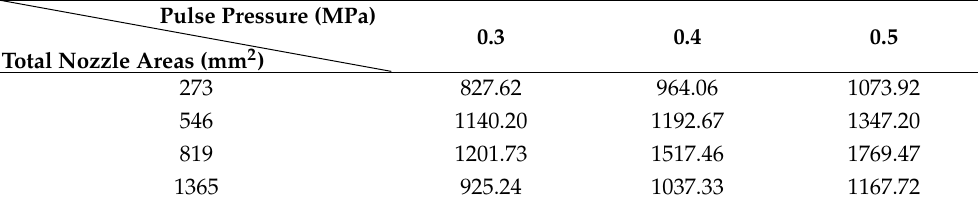
Table 5. The integrated pressure at the nozzles with different pulse